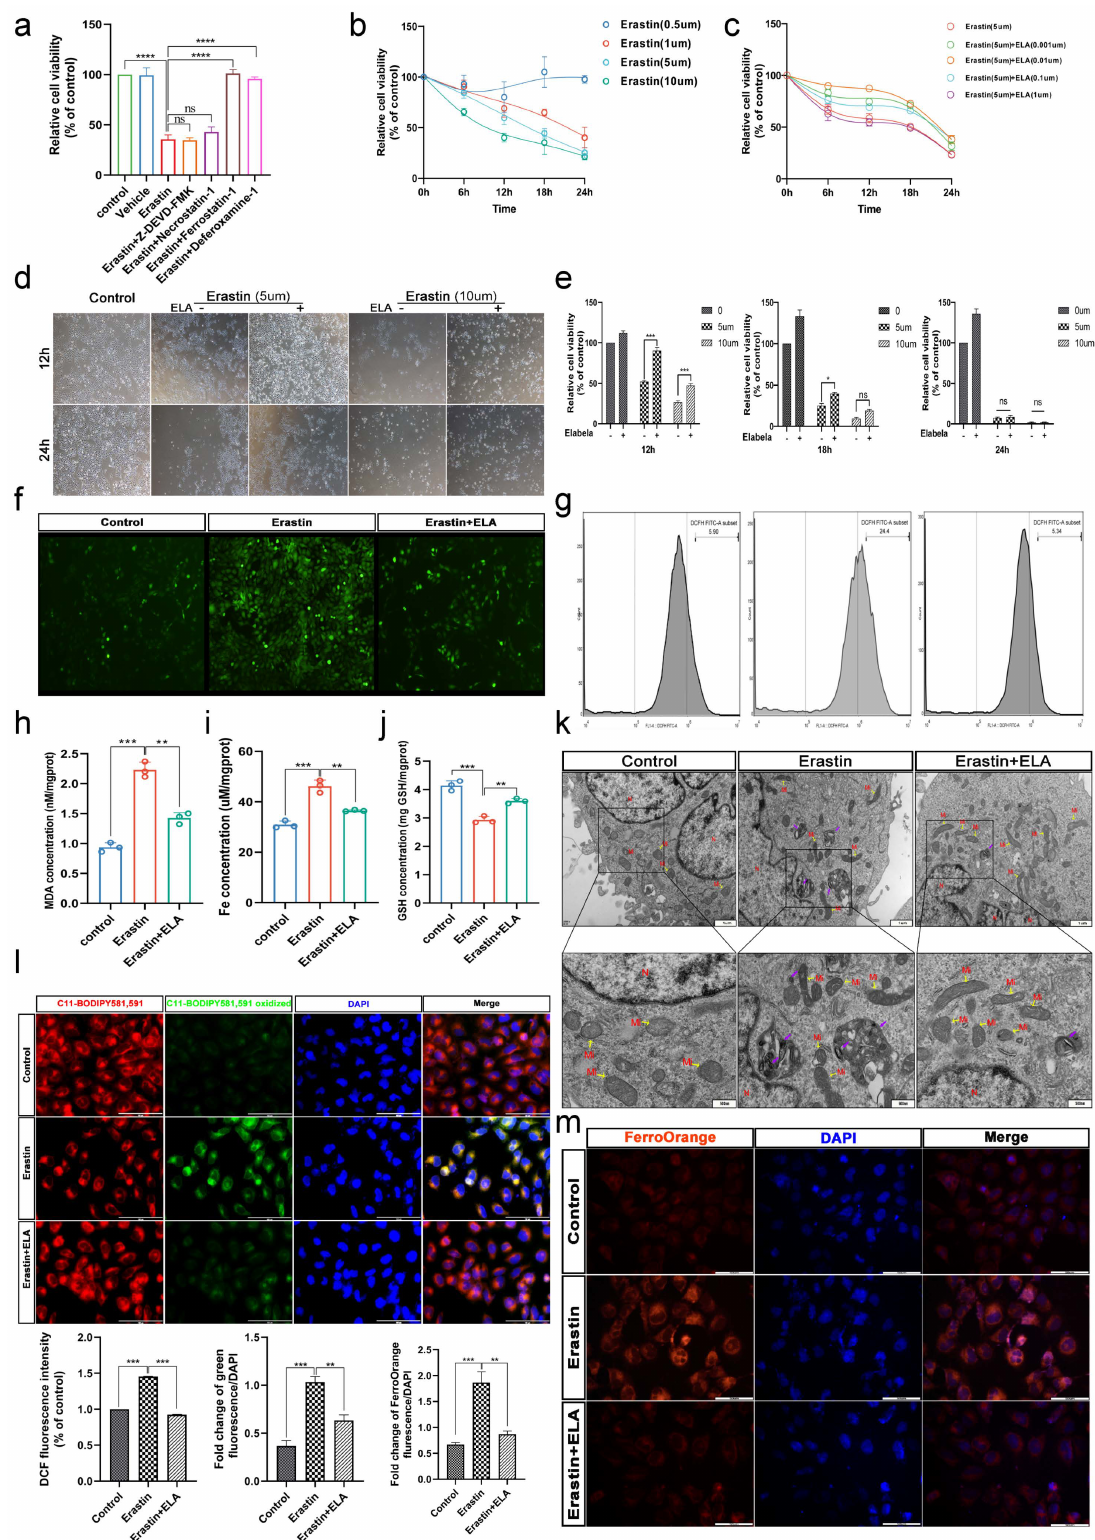
Figure 4. Elabela can rescue ferroptosis induced by Erastin. Construction of the ferroptosis models using Erastin treatment of HTR-8/Svneo cells. ( a ) Pretreatment with apoptosis inhibitor (Z-DEVD- FMK, 20 µ M), necrosis inhibitor (Necrostatin-1, 0.5 µ M), and ferroptosis inhibitor (Ferrostatin-1, 60 nM; Deferoxamine-1 100 µ M) for 1 h, Erastin (5 µ M) was added into cells, and 18 h later, cell viability was determined by CCK8; n = 6. One-way ANOVA and Tukey’s multiple comparison